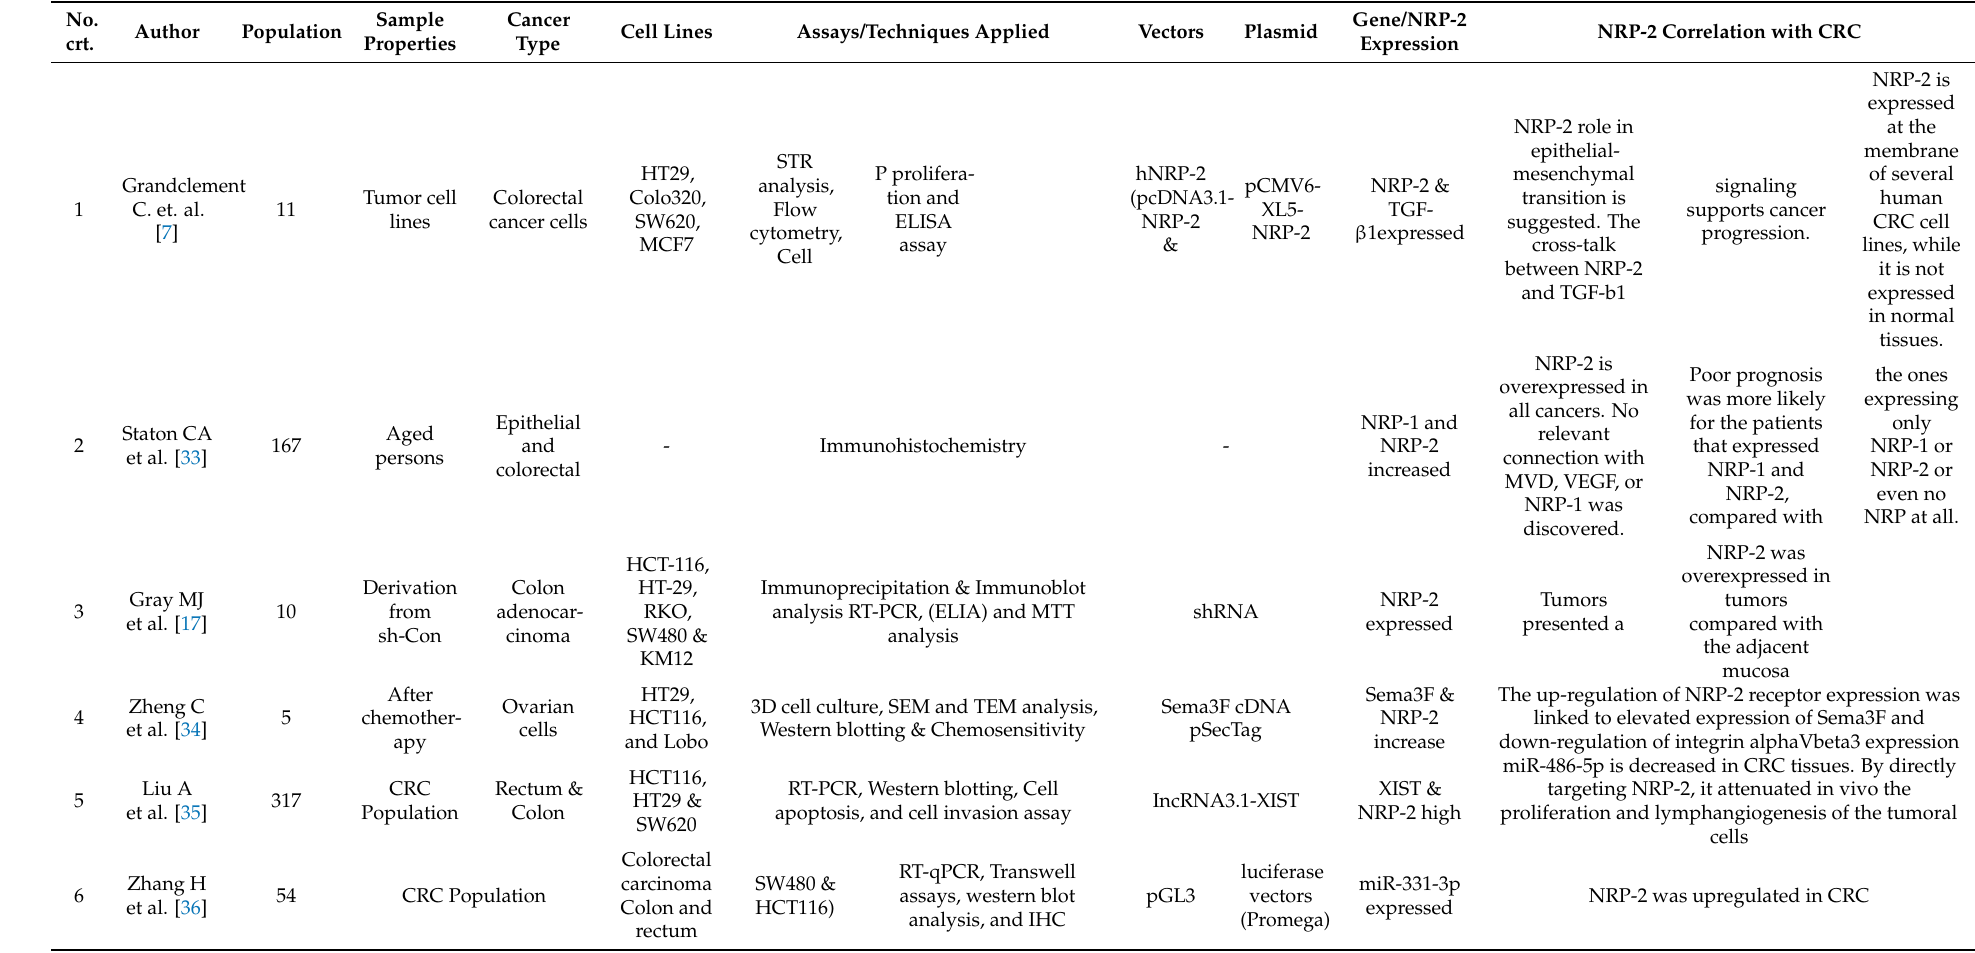
Table 1. Characteristics and summary of included